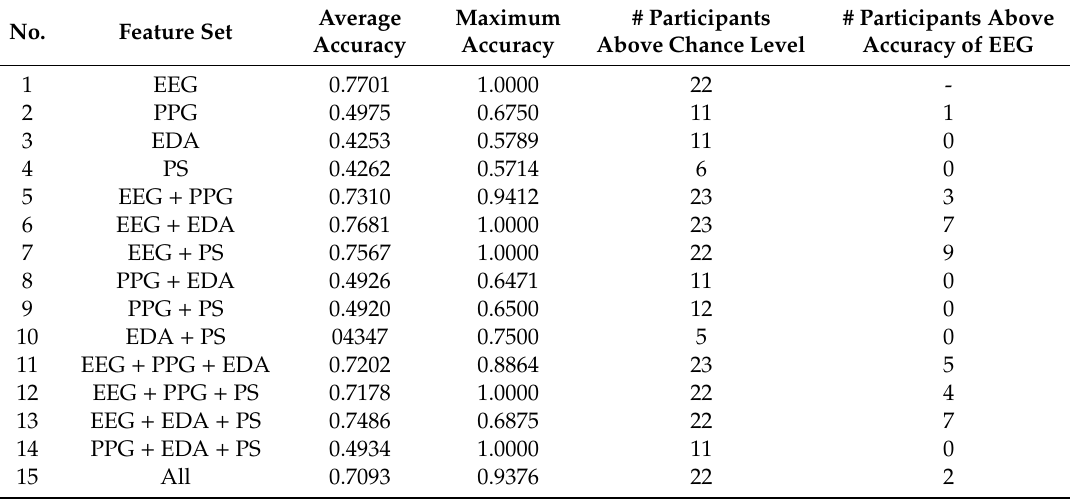
Table 3. The performance comparison between feature